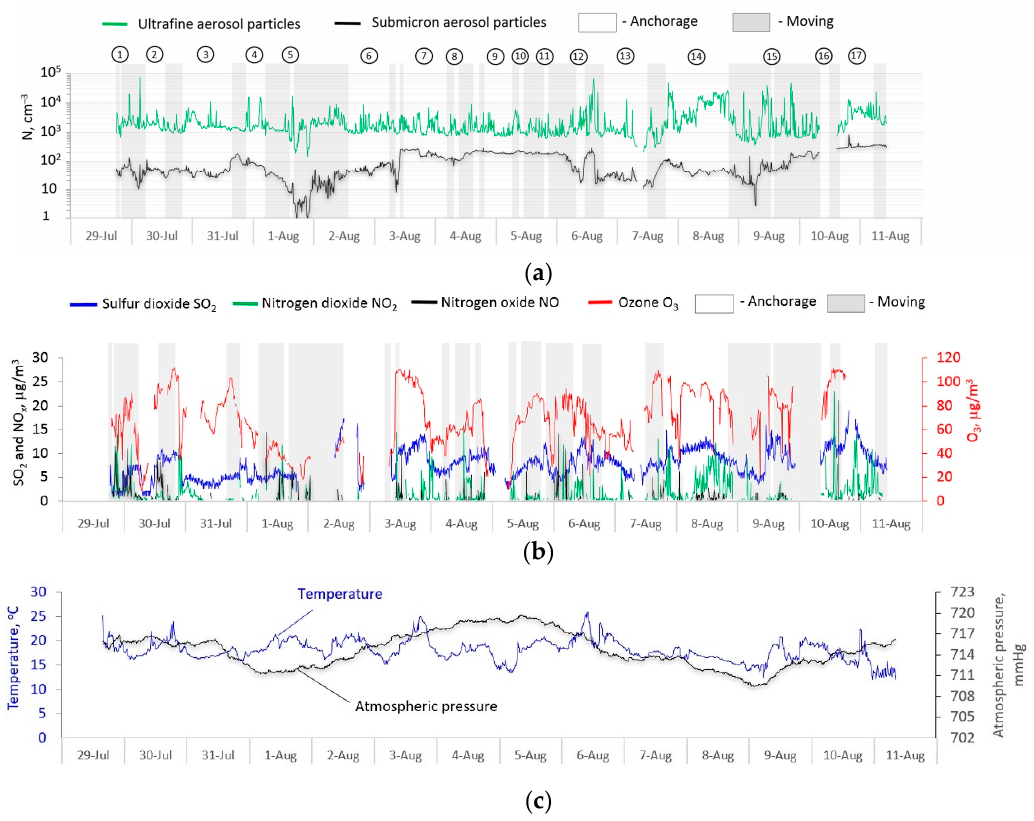
Figure 2. The spatial-temporal variability along the route of the research vessel “Akademik V.A. Koptyug”: ( a ) the concentrations of the ultrafine and submicron atmospheric particles; ( b ) round- level of ozone, nitrogen oxide and dioxide, sulfur dioxide concentrations; ( c ) temperature and pressure; 1-Listvyanka, 2-Baikalsk, 3-Boyarsky, 4-Delta of River Selenga, 5-Island Ogoy, 6-Muzhinay cape, 7-Severobaikalsk, 8-Nizhneangarsk, 9-Ayaya bay, 10-Khakusi, 11-Kabaniu cape, 12-Zmeevaya bay,13-Ust-Barguzin, 14-Turka, 15-Aya bay, 16-Peschanaya bay, and 17-Kadilniy cape.